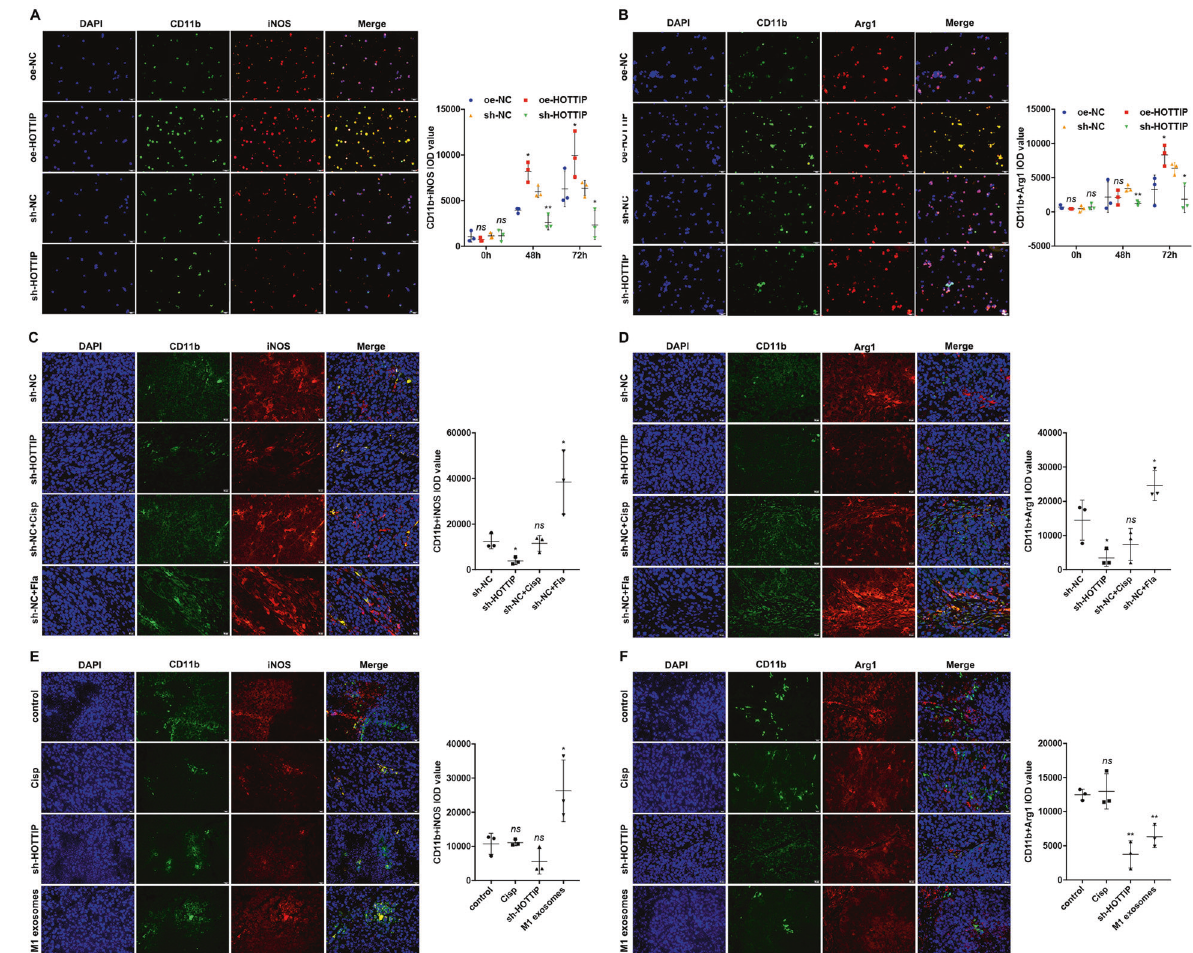
Fig. 6 Cancer cells expressing HOTTIP promote the polarization of local TAMs towards both M1 and M2, but M1 exosomes reeducate TAMs to M1. Immuno fl uorescence (IF) staining assay determined CD11b + iNOS + M1 ( A ) or CD11b + Arg1 + M2 ( B ) phenotype 48 and 72 h post co-culture of cancer cells (upper chamber) and THP-1-derived M0 macrophages (lower chamber). HOTTIP-overexpressed FaDu cells induced polarization while HOTTIP-knockdown Hep-2 cells inhibited polarization of M0 macrophages into both M1 and M2 phenotypes ( n = 3). IF staining detected M1 ( C ) or M2 ( D ) phenotype in tumors derived from HOTTIP-knockdown Hep-2 cells. HOTTIP-knockdown Hep-2 cells suppressed the polarization of M0 macrophages into both M1 and M2 phenotypes ( n = 3). IF staining detected M1 ( E ) or M2 ( F) phenotype in tumors derived from Hep-2 cells treated by M1 exosomes. M1 exosomes induced the polarization of M0 macrophages into the M1 phenotype but inhibited that of M0 ones into the M2 phenotype ( n = 3). Data are presented as mean ± SD. Results were analyzed by One-way ANOVA with a post hoc test. Signi fi cance: * P < 0.05, ** P < 0.01, *** P <